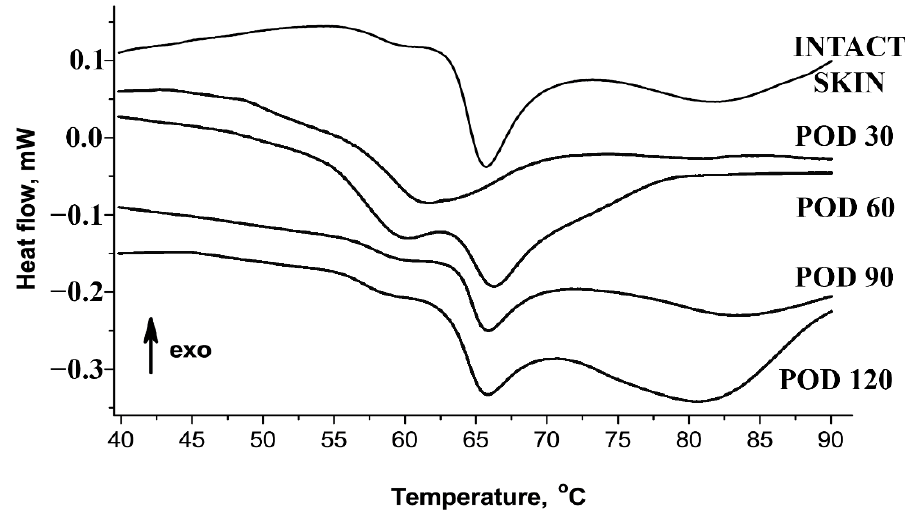
Figure 4. Thermography of skin and scar tissues. Table 2. Temperature picks (Tp) and low-temperature mass portions of thermographs of studied tissues (statistical significance in comparison with the intact tissue: * p ≤ 0.05).